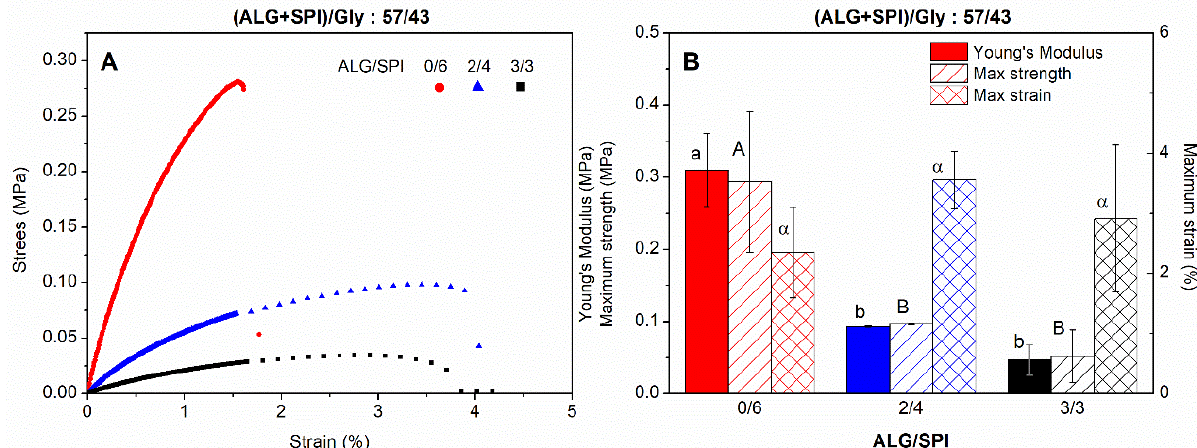
Figure 5. Strain–stress curves ( A ) and main mechanical parameters ( B ) of alginate + soy protein isolate/glycerol composites with different ALG/SPI ratios (0/6, 2/4, and 3/3), keeping the ALG + SPI/Gly ratio at 57/43. Lower-case, upper-case, and Greek letters indicate that average values are statistically different ( p < 0.05).